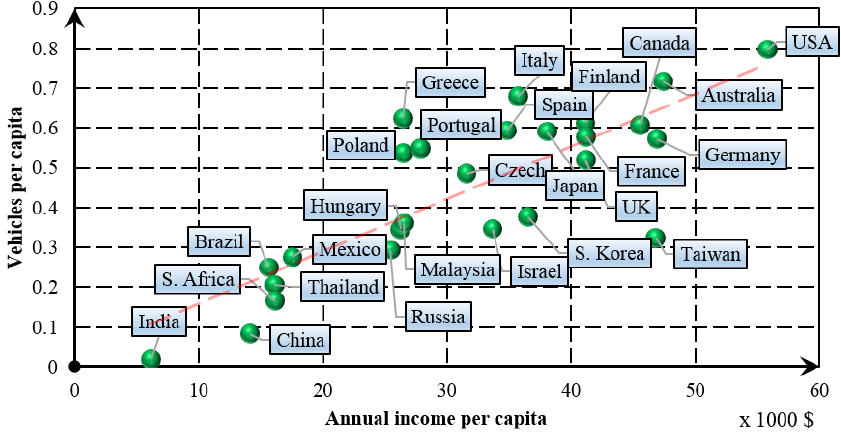
Figure 1. Per capita increase in income leads to increasing individual mobility [4,5].